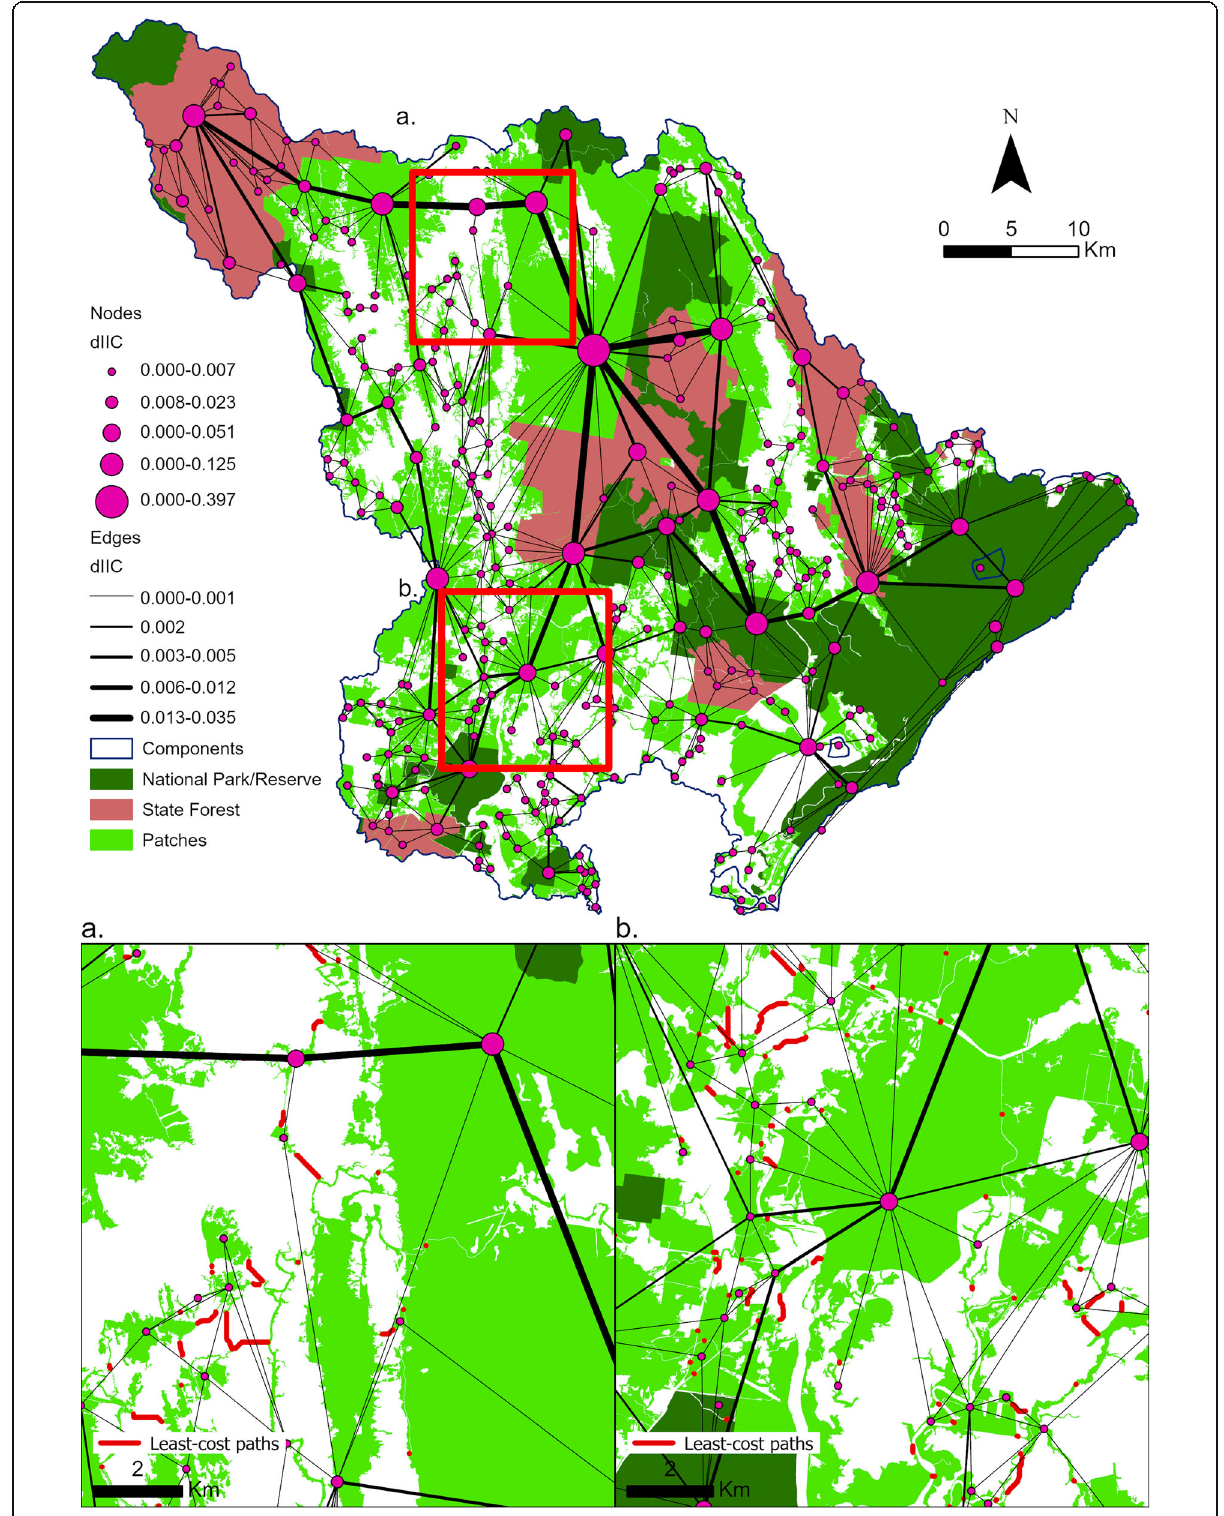
Fig. 7 Habitat patches and protected areas with component boundaries and delta integral index of connectivity (dIIC) for patches and linkages. The importance of linkages and patches is denoted by the thickness of the lines and size of the circles respectively. The circles are located at the centroid of each